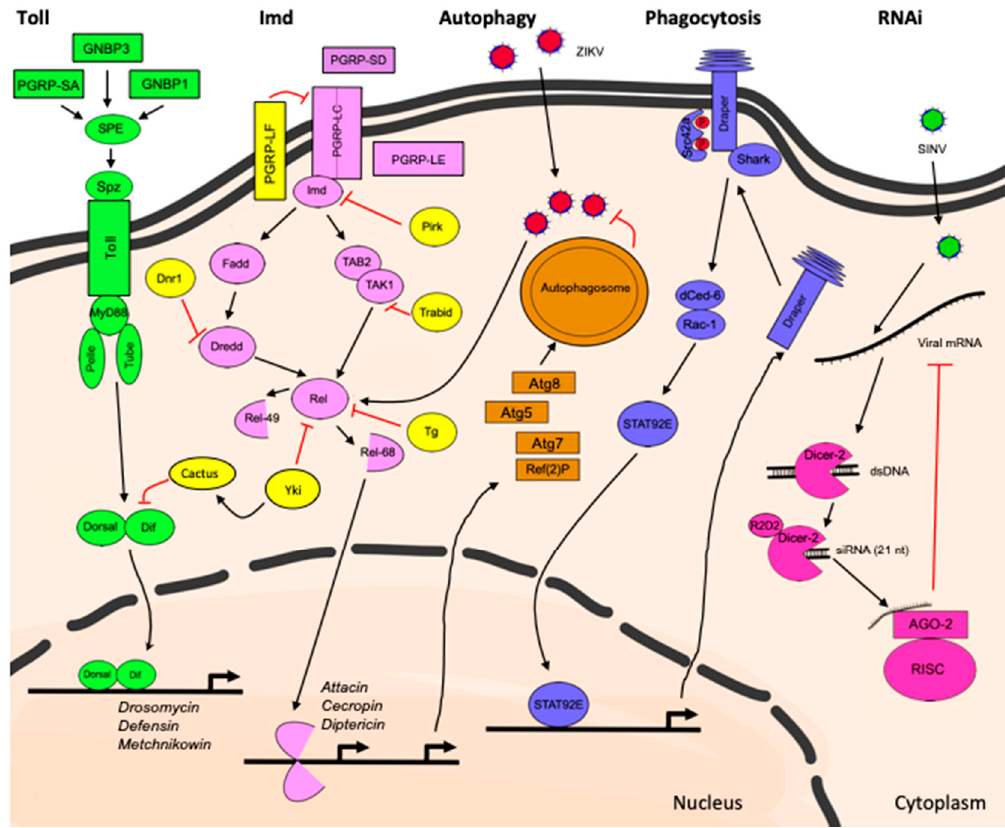
Figure 1. Innate immune pathways activated in the Drosophila brain following injury, infection and neurodegenerative disease.